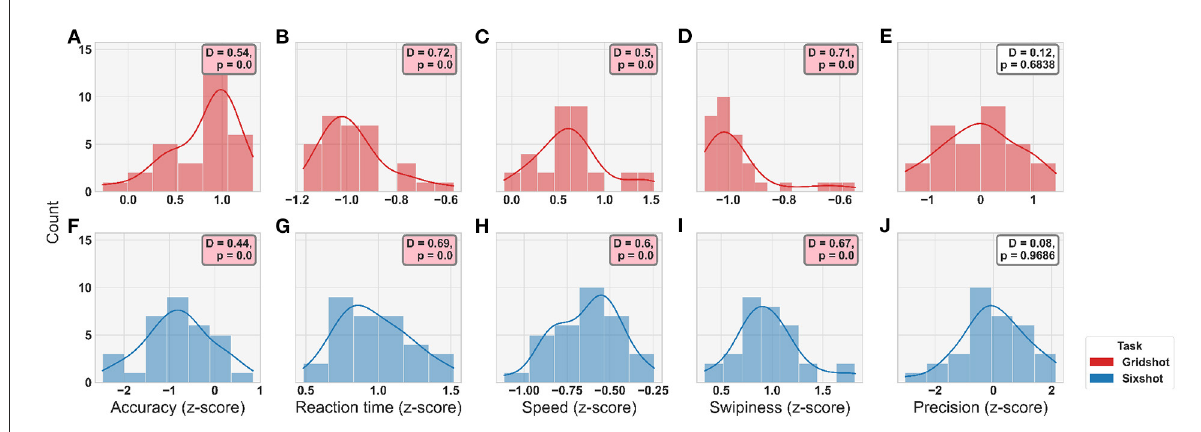
FIGURE3 Distribution plots for each metric by task (see Legend). (A–E) Gridshot. (F–J) Sixshot. Statistical results from Kolmogorov-Smirnov test for normality displayed in annotation boxes; where D, KS-statistic and P, p -value. Pink annotation boxes indicate a p < 0.05.